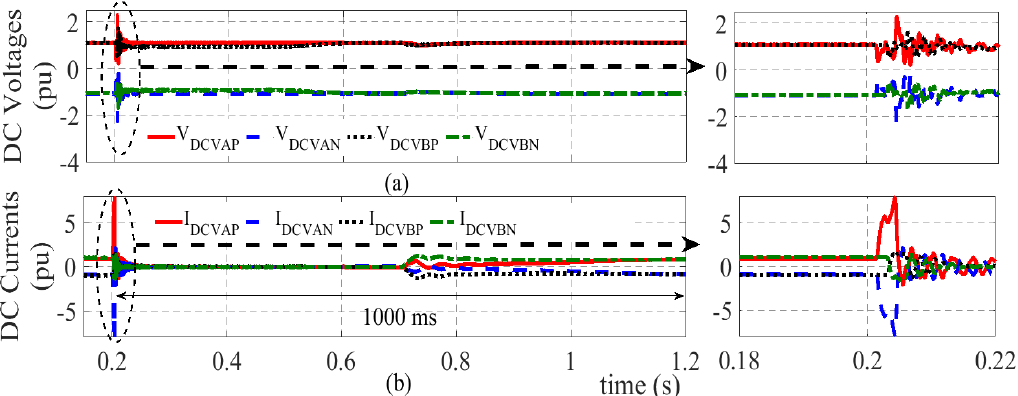
Figure 9. DC side measurements at VSC stations for a P-Pole-to-N-Pole fault on the main transmission line ( a ) voltages, ( b ) currents.